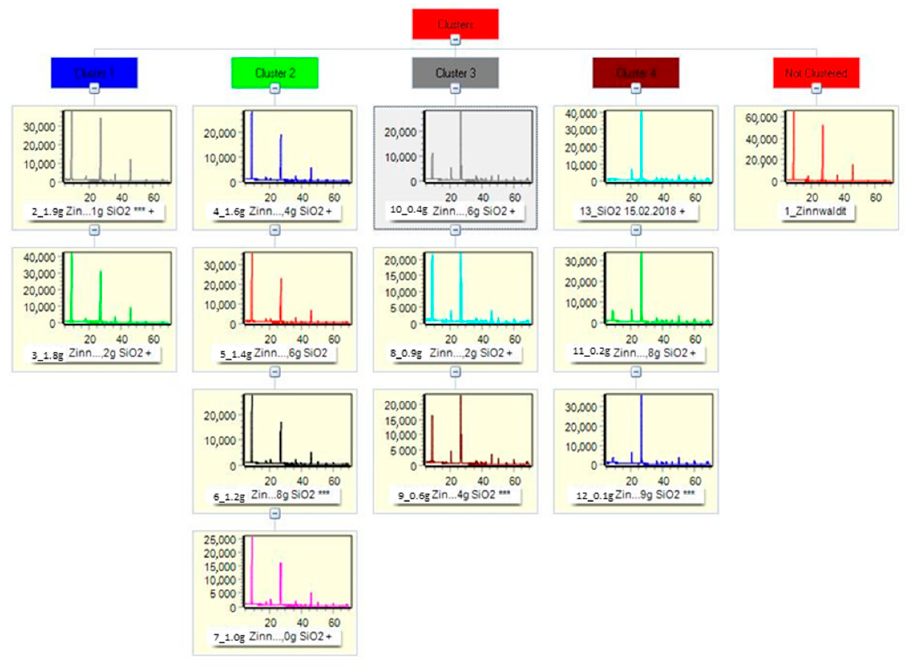
Figure 27. XRD patterns of the different cluster in zinnwaldite–quartz mixtures.